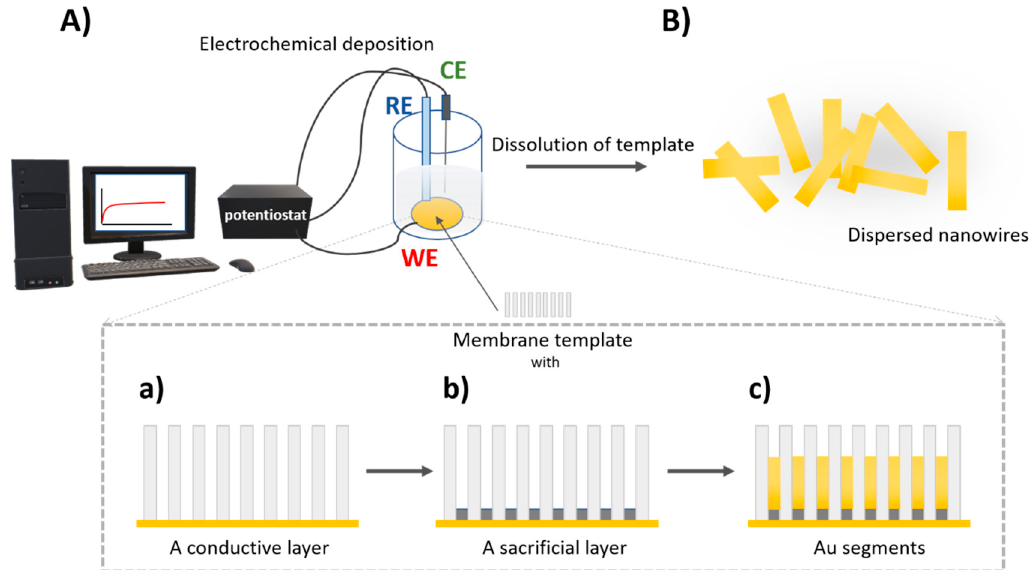
Figure 4. The scheme of preparation of nanowires using a membrane template-assisted electrodeposition ( A ) the three- electrode electrochemical cell using a membrane with a conductive layer as a working electrode (WE), RE — reference electrode, CE — counter electrode. Detailed view of electrodeposition process in a membrane ( a ) a sputtered conductive layer e.g., Au, ( b ) electrodeposition of a sacrificial layer, ( c ) electrodeposition of nanowire Au segment; ( B ) removal of a sacrificial layer and membrane resulting in free nanowires in water.